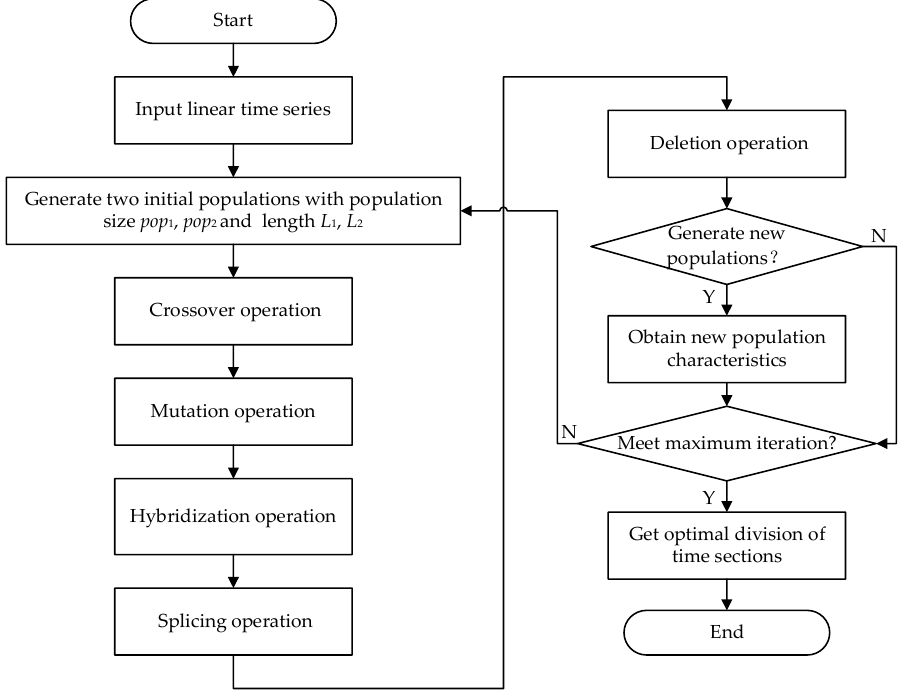
Figure 1. Calculation process of proposed HGAVCL.